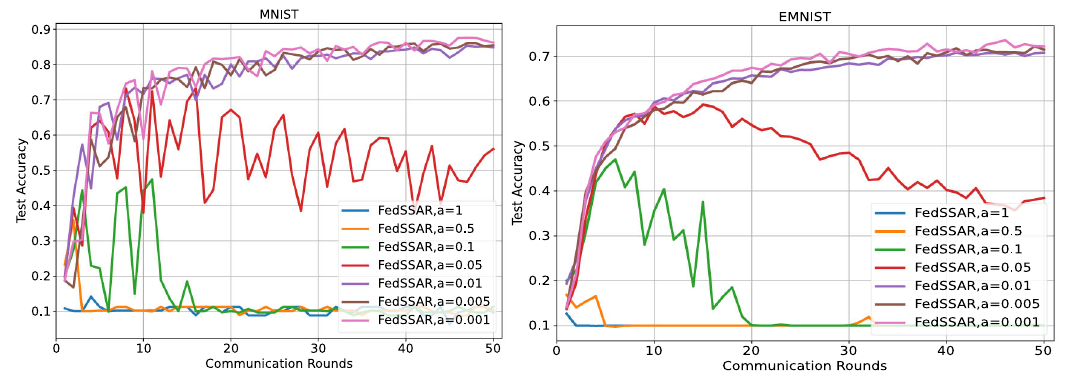
Fig. 11 MNIST and EMNIST-L α sensitivity of FedSSAR